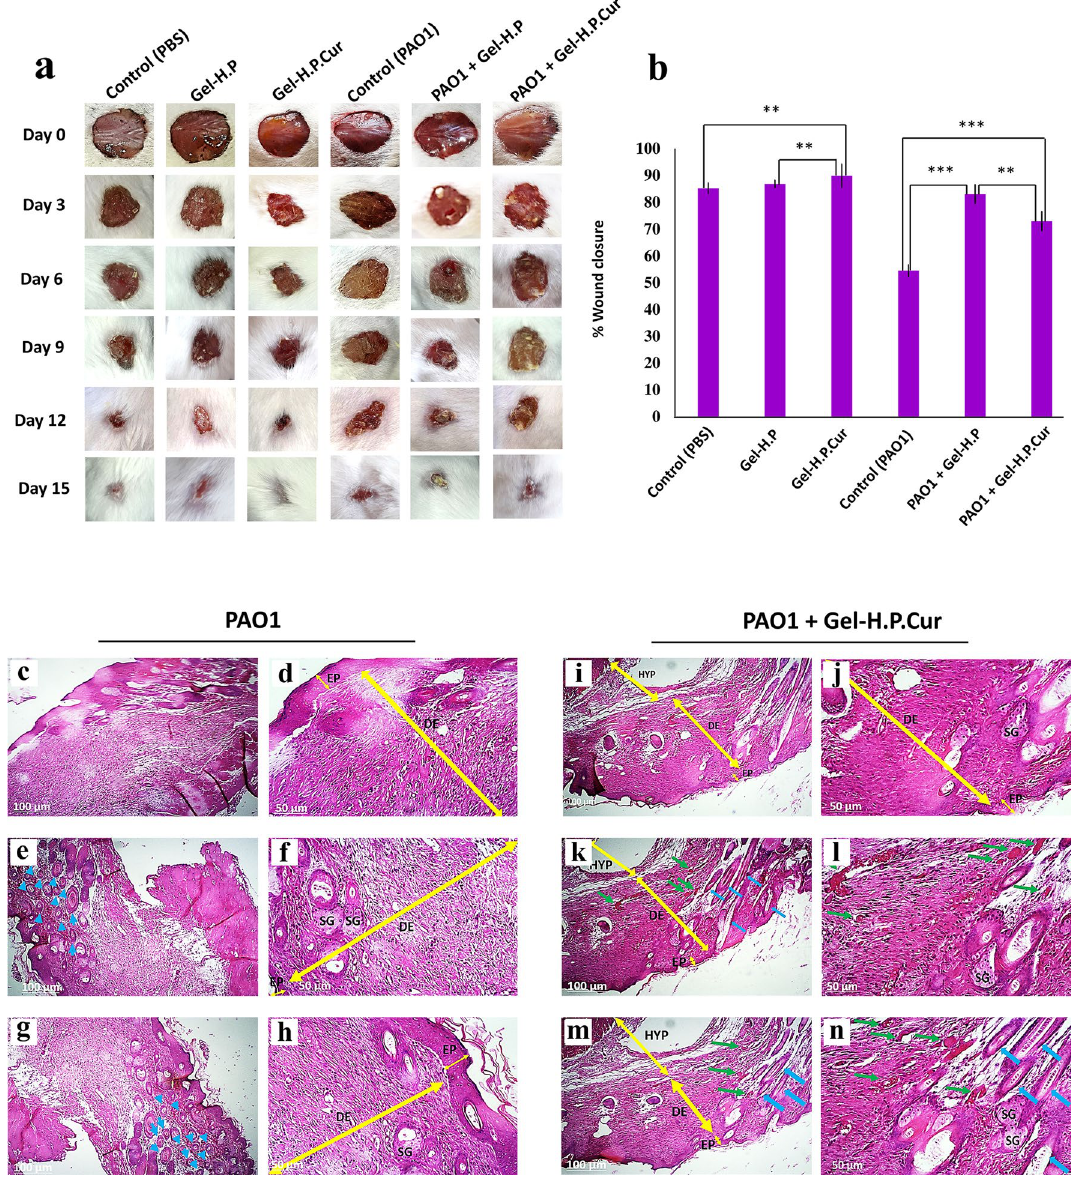
Fig. 4 Macroscopic and microscopic photographs of wound healing. a Wound healing appearances in all control and treated (Gel-H.P or Gel-H.P.Cur/infected or non-infected) groups (Three mice in each group) on days 0, 3, 6, 9, 12 and 15 were recorded using a digital camera. All of the treatments were performed only once on wounding day (day 0) and the healing process was followed until day 15. b Wound closure rate (%) of 6 groups on the day 12 next to post wounding. Wound area was measured using Image J software and the ratio of the wound size on the 12th to the zero days was calculated (mean SD, * P < 0.05, ** P < 0.01, *** P < 0.001). c – n Histopathological evaluation of the wounds using H&E staining on ± day 15 post-wounding. c , d , e , f , g and h are the control group (Table 1, group 4, P. aeruginosa : infected with 100 µL of P. aeruginosa (0.5 McFarland) without any treatment), while i , j , k , l , m and n are the treated group (Table 1, group 6, PAO1 Gel-H.P.Cur: infected with 100 µL of P. aeruginosa (0.5 + McFarland) treated with Gel H.P.Cur). EP epidermis, DE dermis, HYP hypodermis, SG sebaceous glands, yellow arrows: EP, DE or HYP, blue arrows: + hair follicles, green arrows: blood